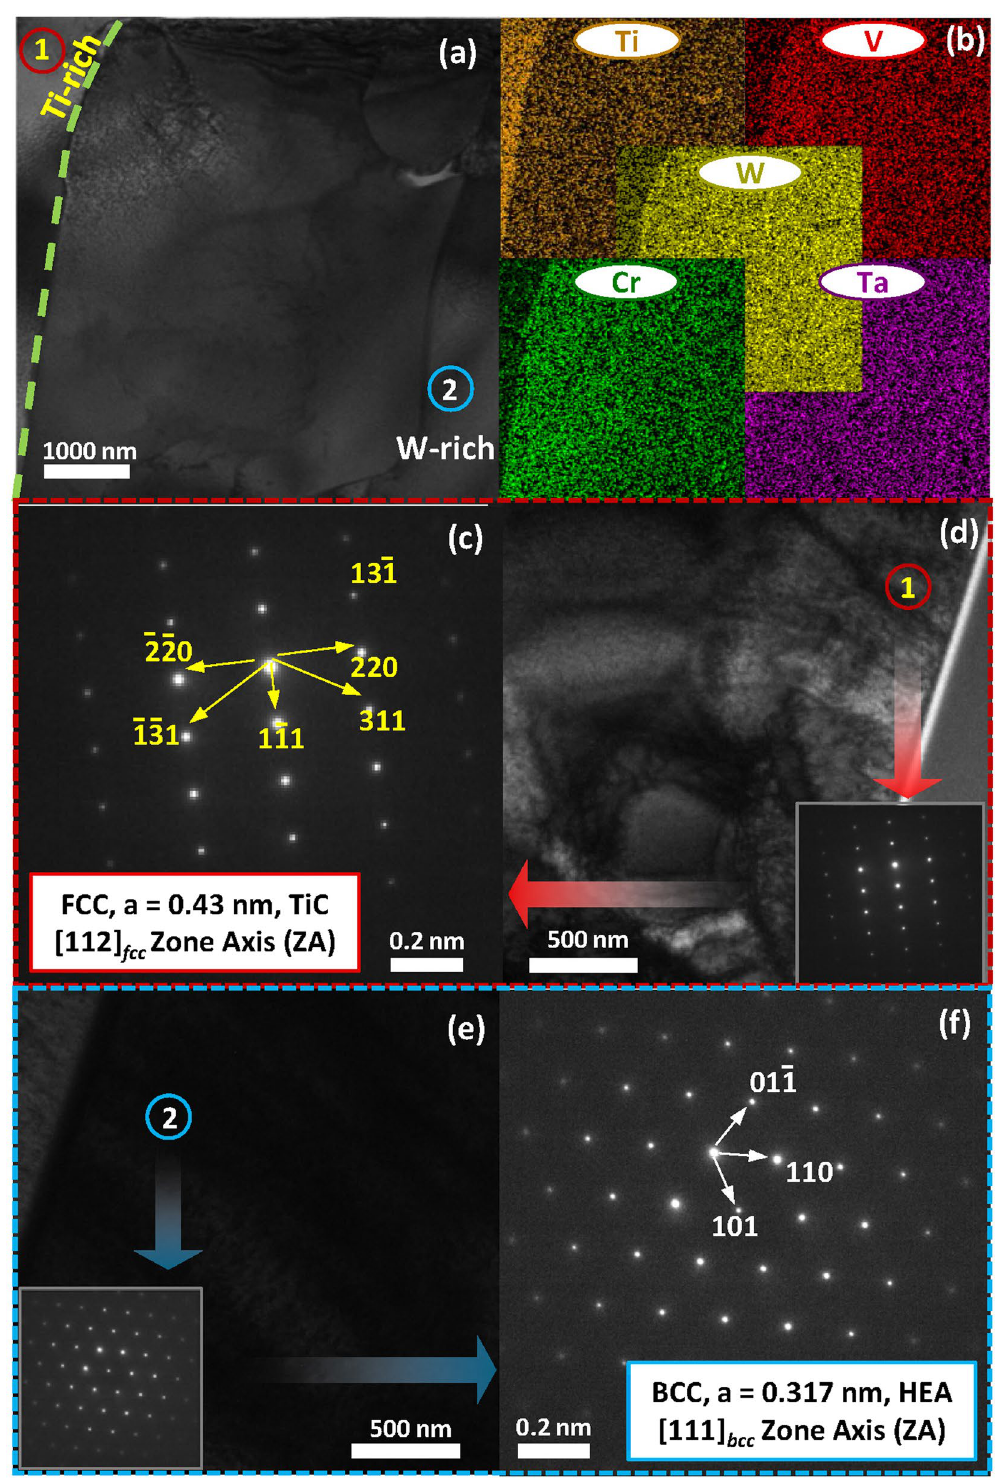
Figure 4. ( a ) TEM microstructure, ( b ) elemental mapping, ( c and d ) SADP of TiC and ( e and f ) SADP of the HEA phase as observed in 32 W s